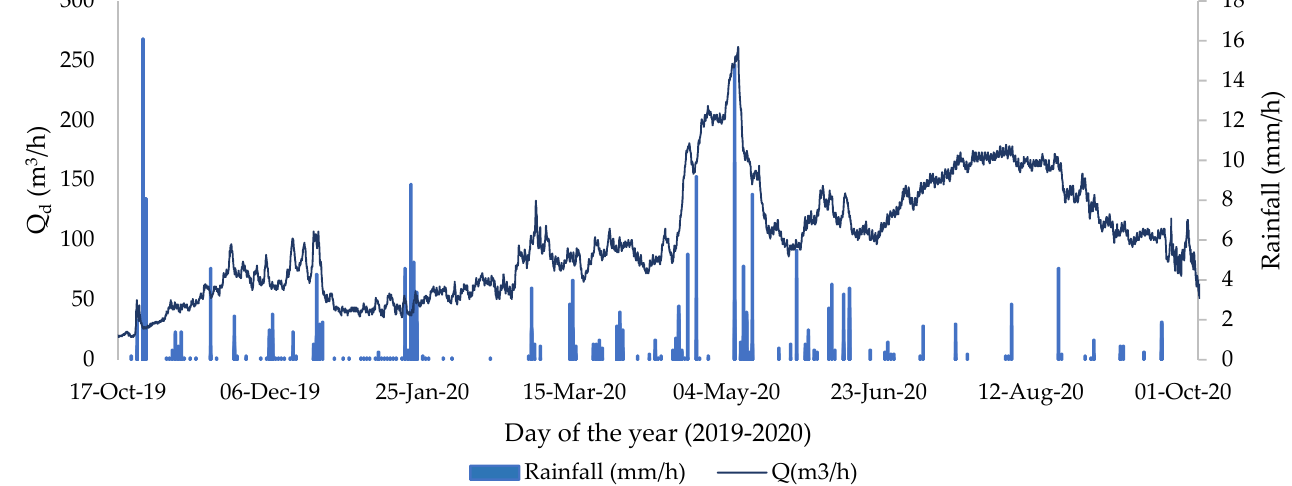
Figure 3. Drainage water flow (Q d , m 3 /h) in the outlet and rainfall (mm/h) episodes during the study